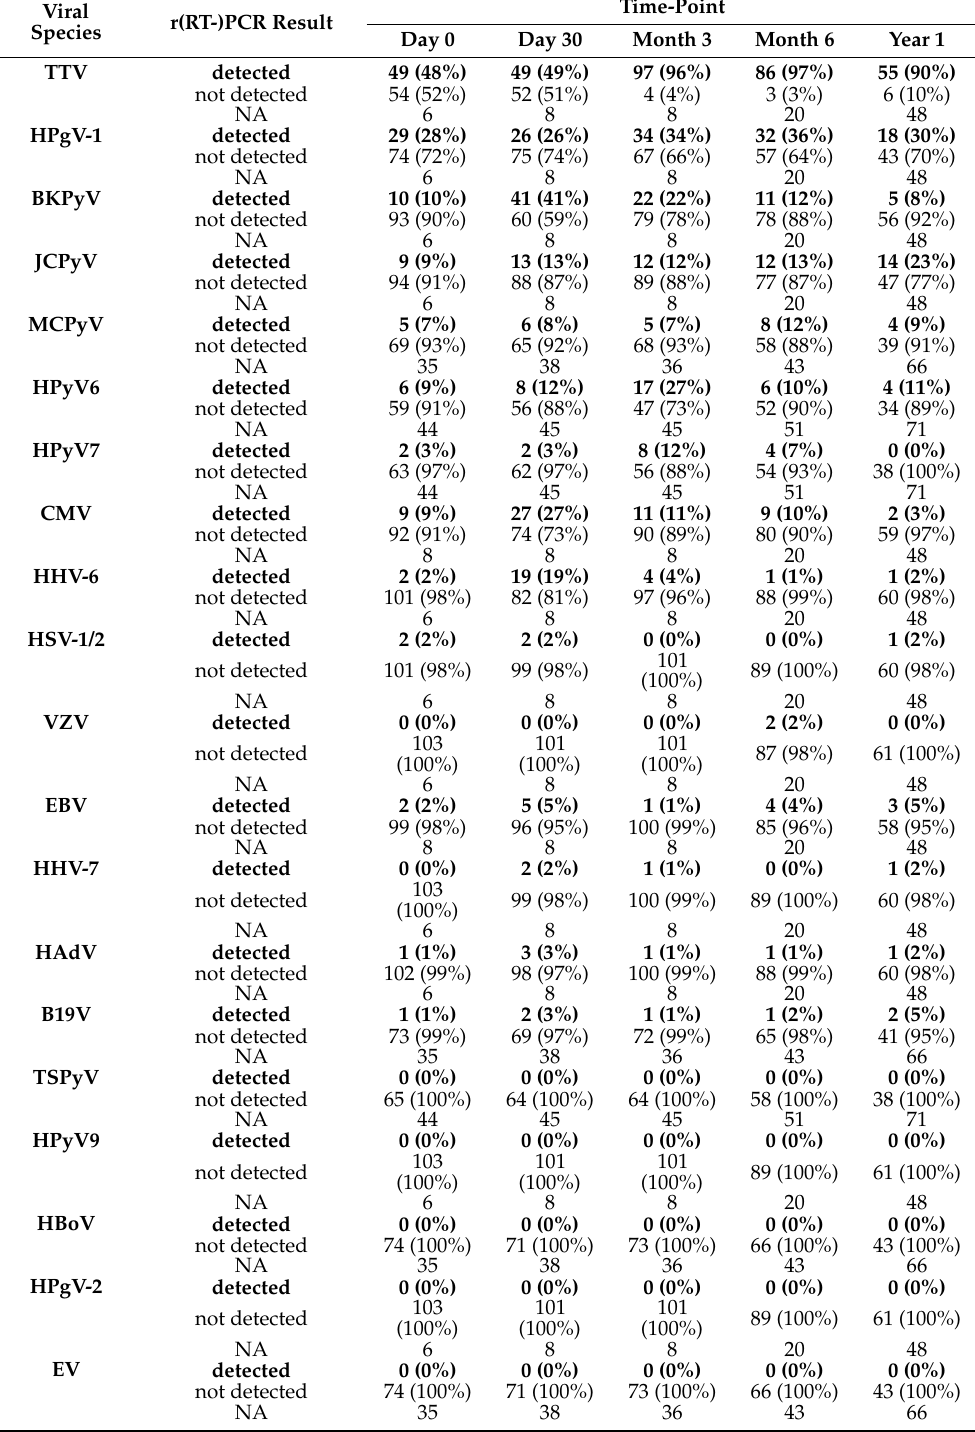
Table 4. Point prevalence of 20 viruses in plasma samples of 109 HSCT